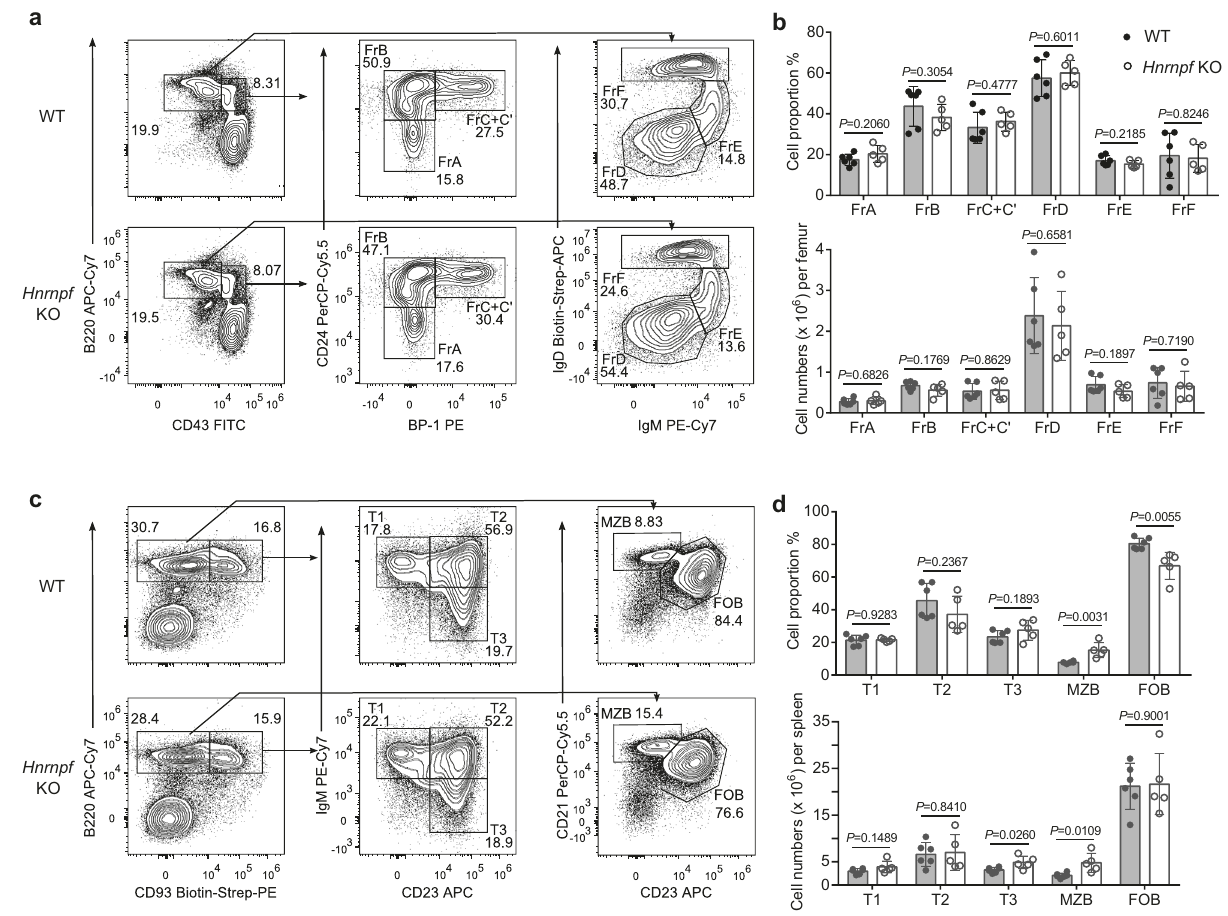
Fig. 1 | hnRNP F-de fi cient mice have normal B cell development. a , b Flow cytometric analysis of B cells in the BM. The frequencies ( a ) and numbers ( b ) of various B cell subsets in the BM of WT and Hnrnpf KO mice were analyzed and enumerated using Hardy ’ s gating strategy ( n =6 for WT group and n =5 for Hnrnpf KOgroup). c , d FlowcytometricanalysisofBcellsinthespleen.Thefrequencies( c ) andnumbers( d )ofdifferentsplenicBcellsubsetsinWTand Hnrnpf KOmicewere